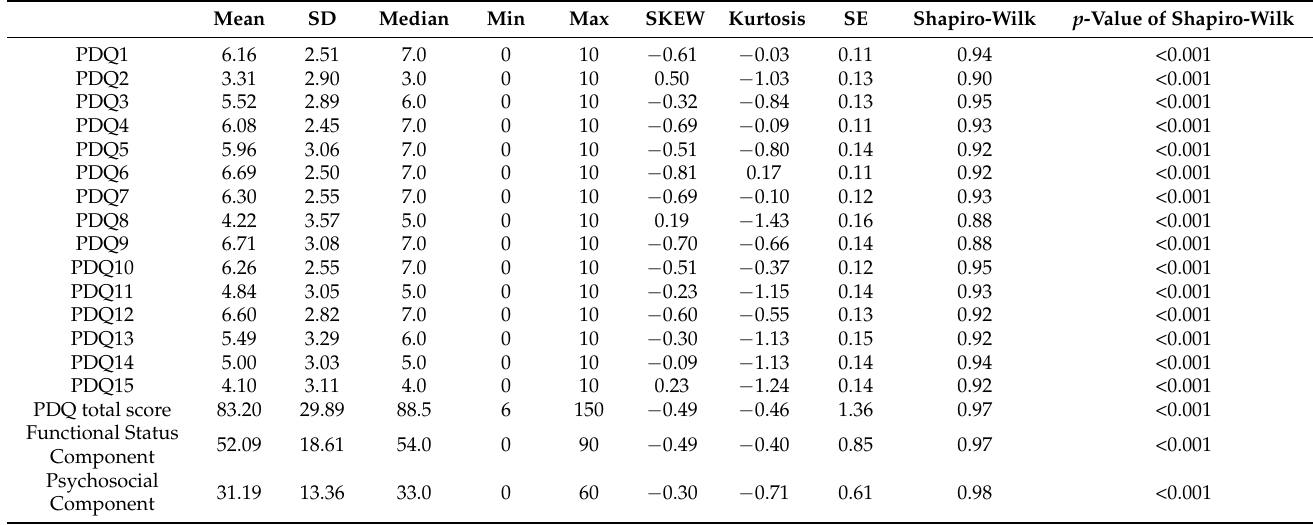
Table 2. Descriptive statistics ( N =